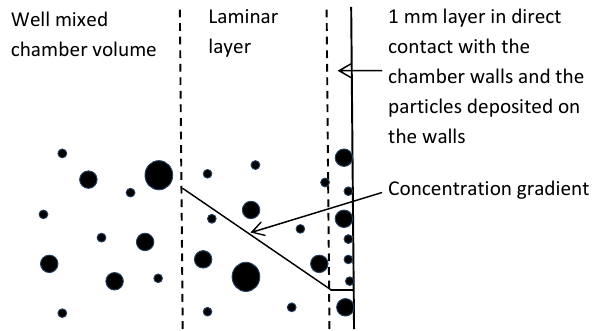
Figure 2. Schematic figure which illustrates how ADCHAM treat the diffusion limited mass transfer of gas phase compounds across a laminar layer next to the chamber walls. The thin (1 mm thick) air layer next to the chamber walls is treated as a separate volume which exchange gas phase compounds with the well mixed chamber and the walls + wall deposited particles.